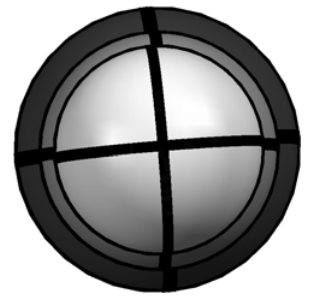
Figure 6. Thermal ellipsoids of the oxygen atoms of ice I 0.1 mm capillaries at 150 K, 195 K and 240 K (from light to dark grey respectively). The three ellipsoids are shown at the same probability